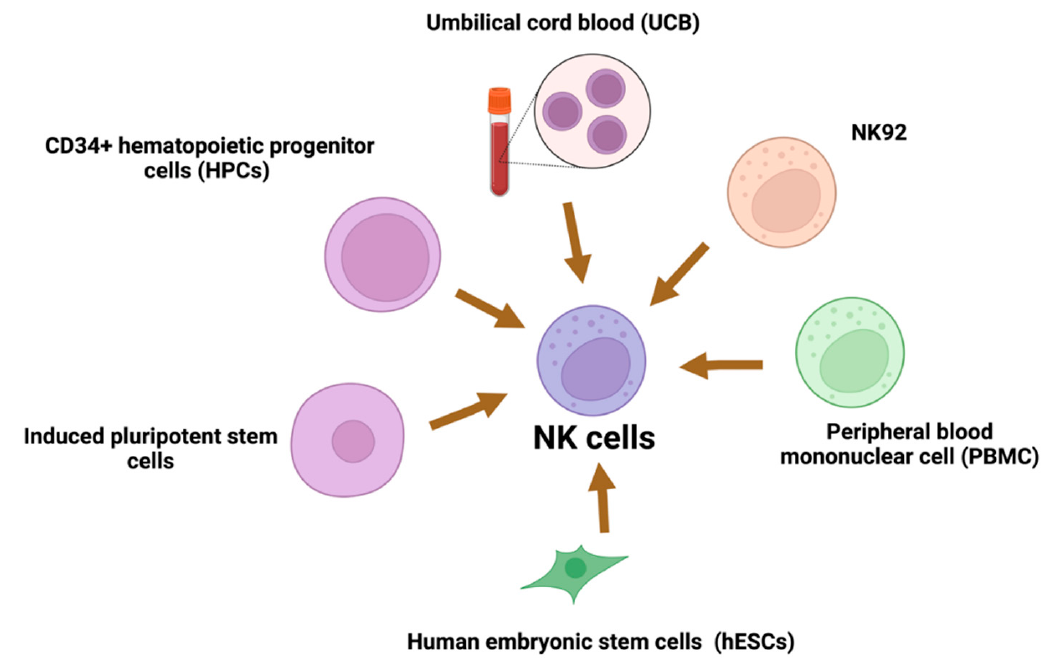
Figure 4. Sources of NK